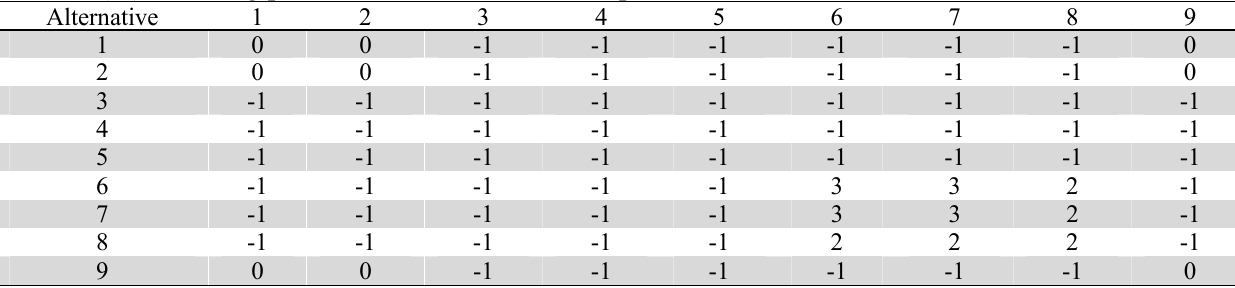
Matrix ( S 6 ) at slicing parameter θ 6 = 0.60 for example 1